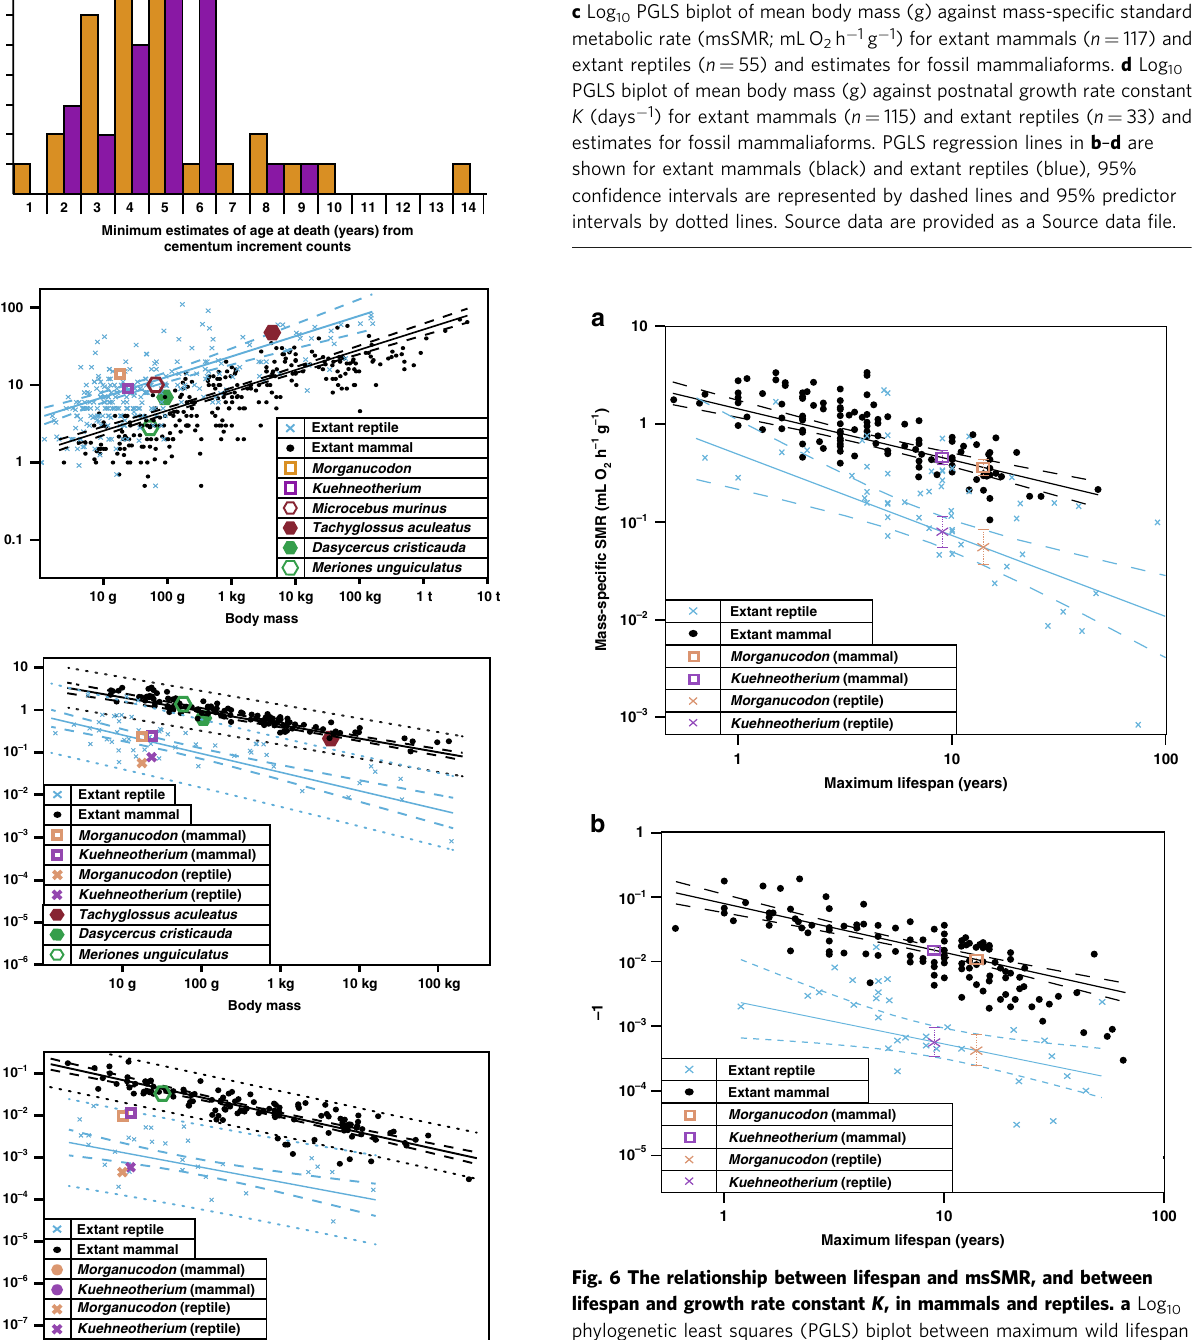
Fig. 6 The relationship between lifespan and msSMR, and between lifespan and growth rate constant K , in mammals and reptiles. a Log 10 phylogenetic least squares (PGLS) biplot between maximum wild lifespan (years) and mass-speci fi c standard metabolic rate (msSMR; mL O 2 h − 1 kg 1 ) for extant mammals ( n = 117) and reptiles ( n = 55). b Log 10 PGLS biplot between maximum wild lifespan (years) and postnatal growth rate constant K (days − 1 ) for extant mammals ( n = 115) and reptiles ( n = 31). PGLS regression means for each clade (black lines for mammals, blue lines for reptiles, dashed lines denote 95% con fi dence intervals) are used to estimate msSMR and K for mammaliaforms Morganucodon and Kuehneotherium , with dashed brackets denoting their 95% con fi dence intervals. Source data are provided as a Source data fi